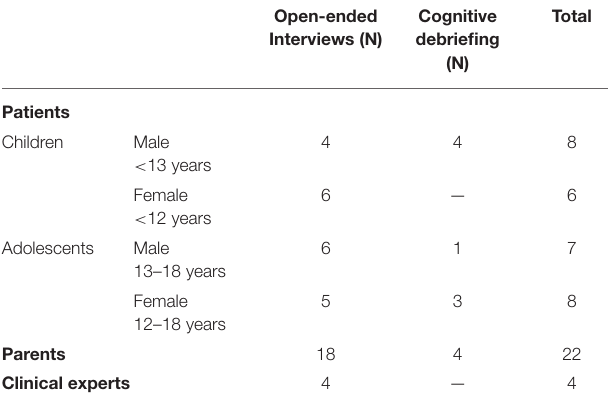
TABLE 1 | Number of participants in open-ended interviews and cognitive